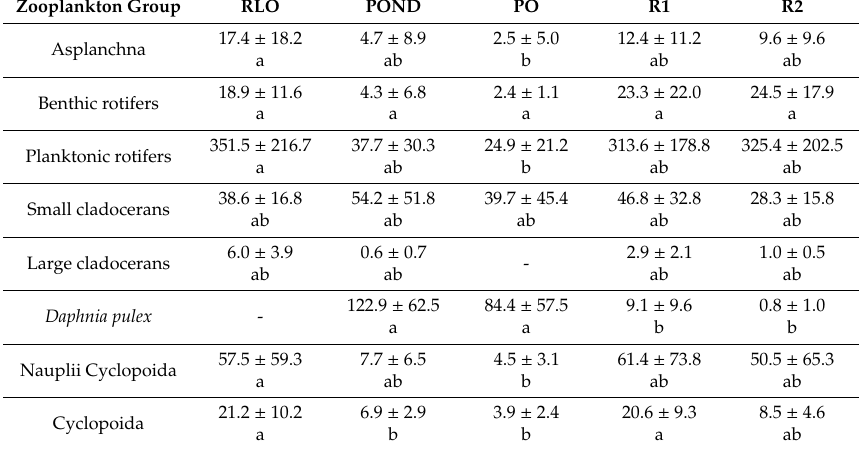
Table 2. Mean ± SD of the zooplankton groups abundance at examined sites ( n = 4). Di ff erent letters in rows show significant di ff erences between sites (post-hoc multiple comparisons of mean ranks for all groups p < 0.05).